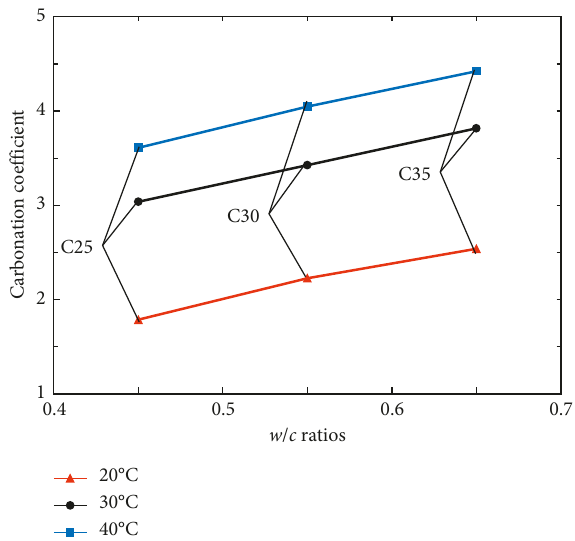
Figure 12: Fitting curves of the water-cement ratio and the carbonation rate